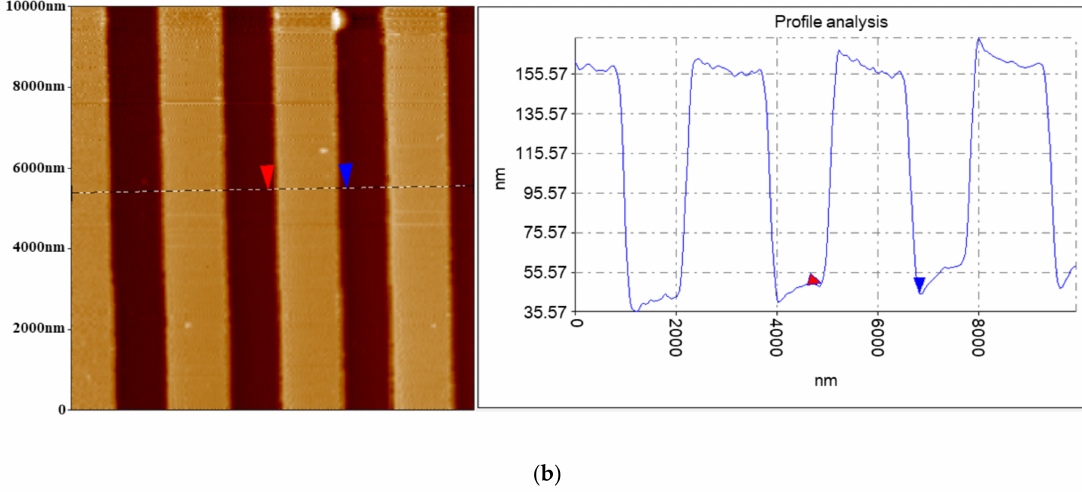
Figure 9. The scanning results for calibration grating (tipsnano, Tallinn, Estonia) ( a ) using the fabricated probe and ( b ) using a commercial probe.